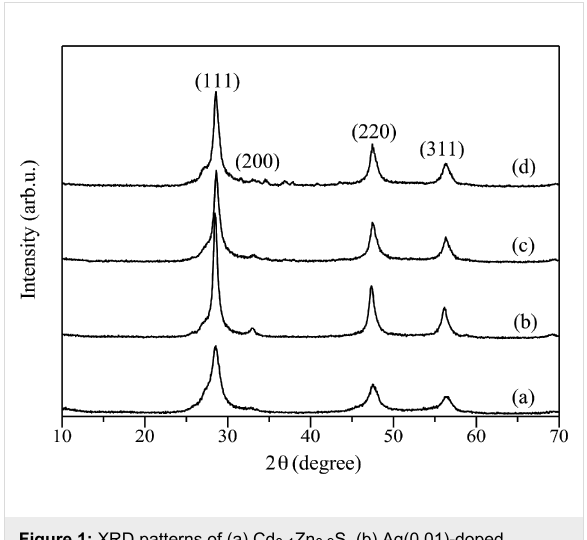
Figure 1: XRD patterns of (a) Cd 0.1 Zn 0.9 S, (b) Ag(0.01)-doped Cd 0.1 Zn 0.9 S, (c) Ag(0.03)-doped Cd 0.1 Zn 0.9 S, and (d) Ag(0.05)-doped Cd 0.1 Zn 0.9 S prepared by the hydrothermal